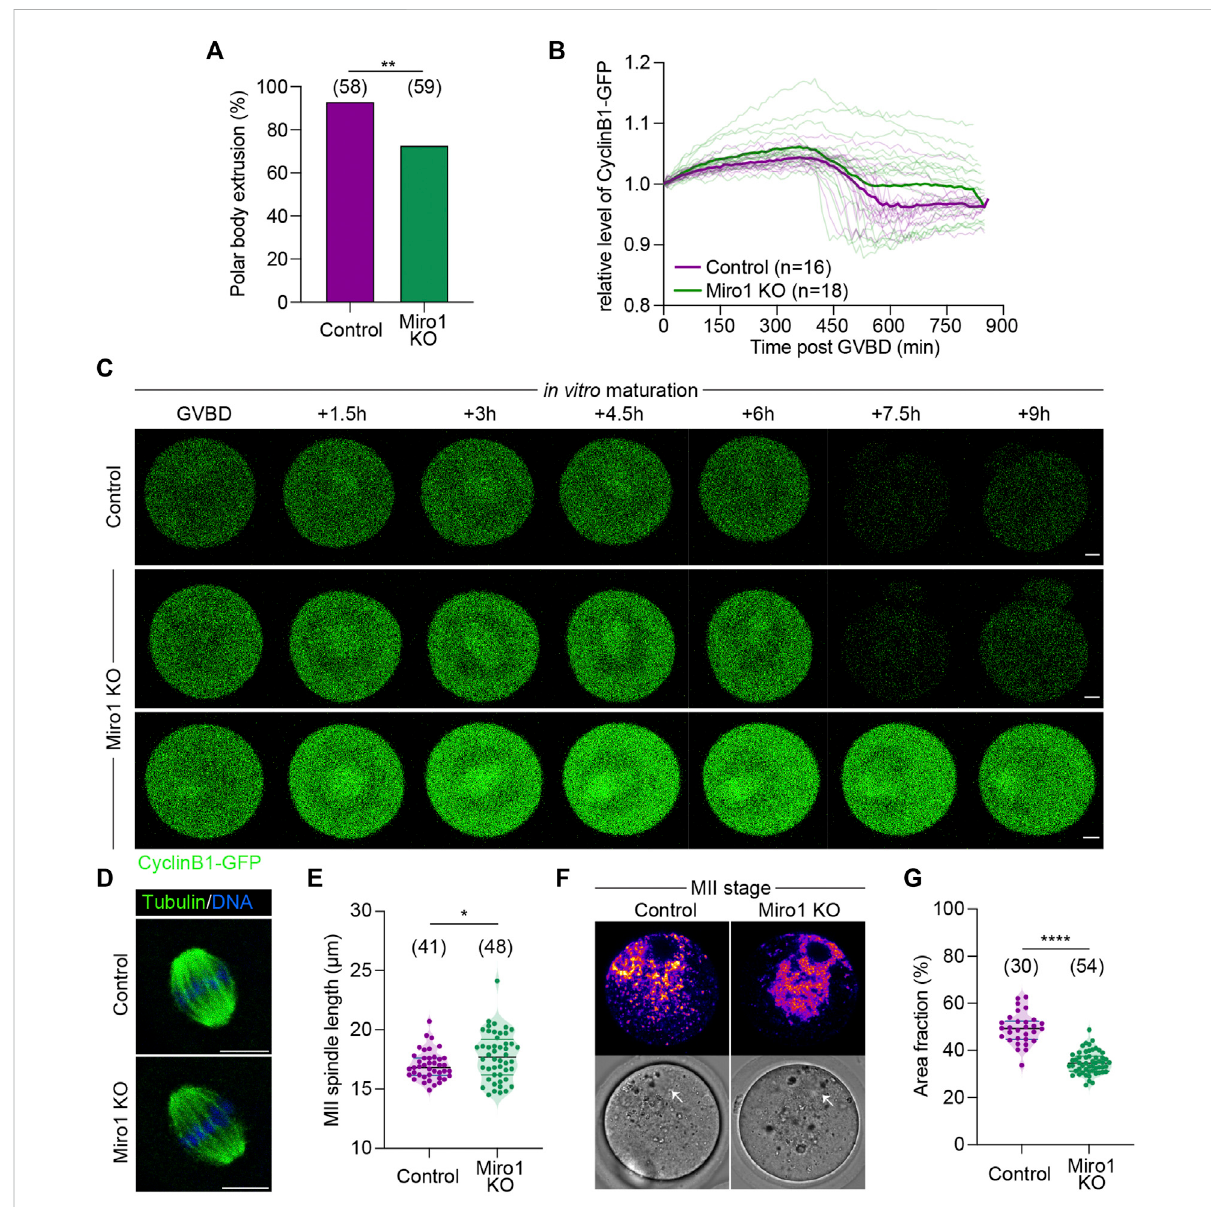
EffectsofMiro1deletiononmouseoocytematuration. (A) Percentageofthe fi rstpolarbodyextrusionincontrolandMiro1KO.Chi-square** p < 0.01. (B) Normalized fl uorescenceintensityofCyclinB1-GFPduringoocytematurationincontrol( n =16)andMiro1KO( n =18).Paired t -test,**** p < 0.0001 (C) Time-lapse image of maturing control and Miro1 KO. Green: Cyclin B1-GFP. Scale bar: 10 µm. (D) Morphology of bipolar spindles observed in ovulated controls and Miro1 KO. Green: a-Tubulin and Blue: DNA. Scale bar: 10 µm (E) Length of the second meiotic spindle. Unpaired t -test * p < 0.05. Data are collated from 3 independent experimental replicates. (F) Mitochondrial distribution in ovulated controls and Miro1 KO. Fire: TMRM. White arrow: spindle. Scale bar: 10 µm (G) Percentage of area fraction measured at ROIs (white dashed line) in control